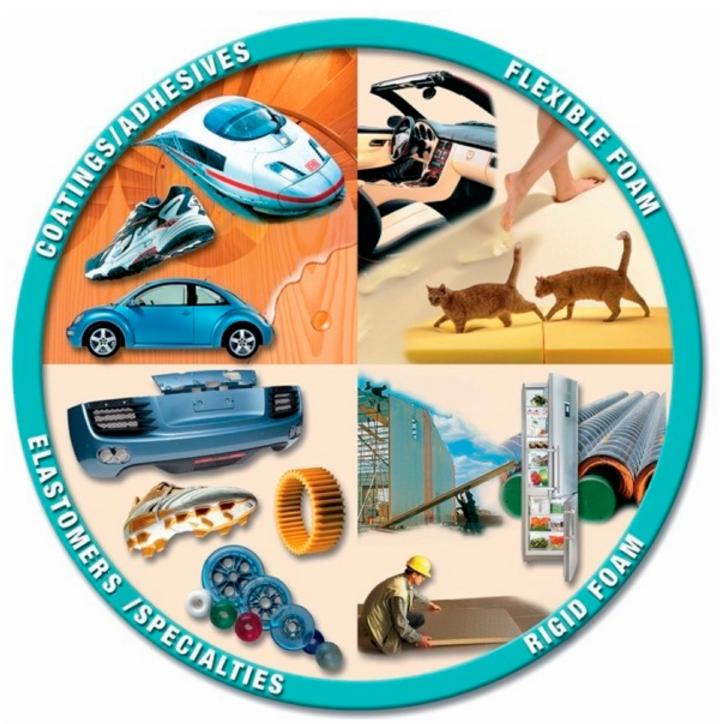
Figure 1. Related applications of PU materials [7]; used with permission from Angewandte Chemie International Edition, John Wiley and Sons, 2021.